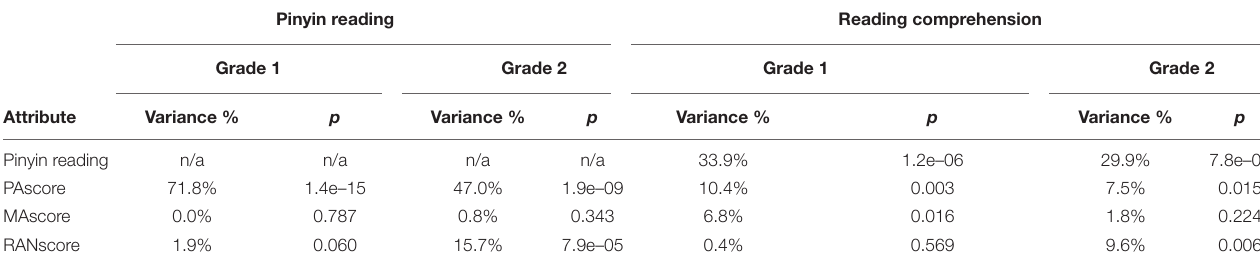
TABLE 1 | Variance explained by each attribute in reading outcome * . Pinyin reading Reading comprehension